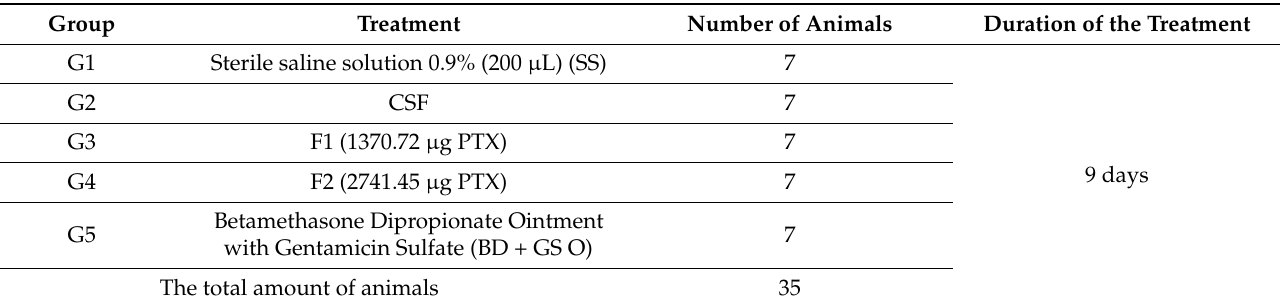
Table 1. Description of the study groups ( n = 7), evaluated in treatment and control groups, used for the wound healing trial lasting 9